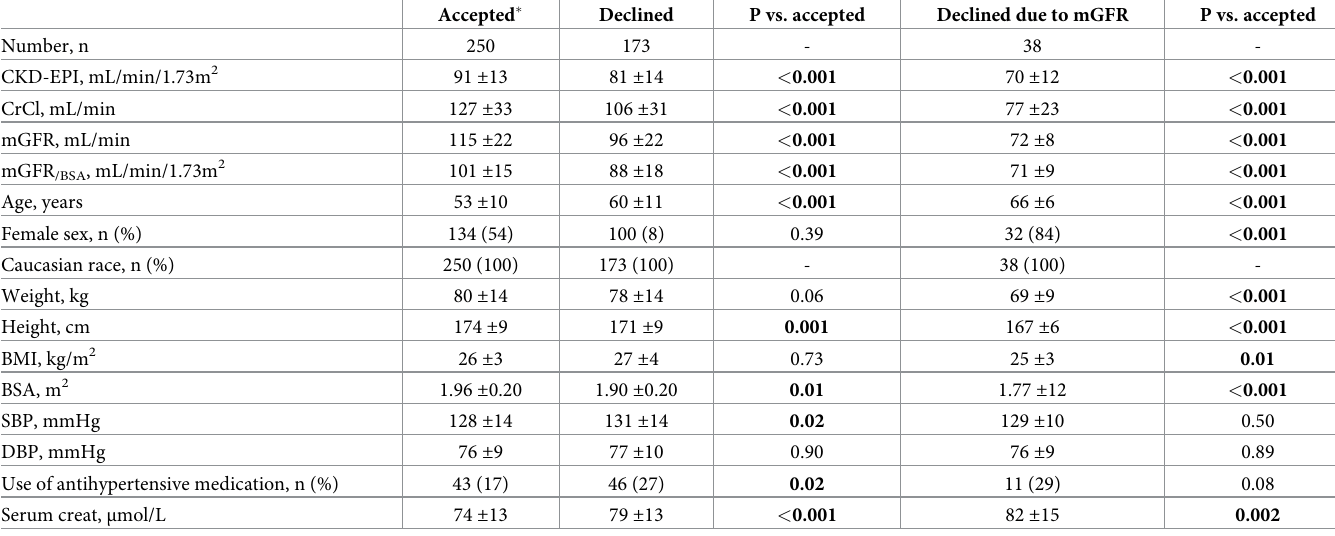
Table 5. Characteristics of “accepted”, “declined” and “declined due to low mGFR” donors in the